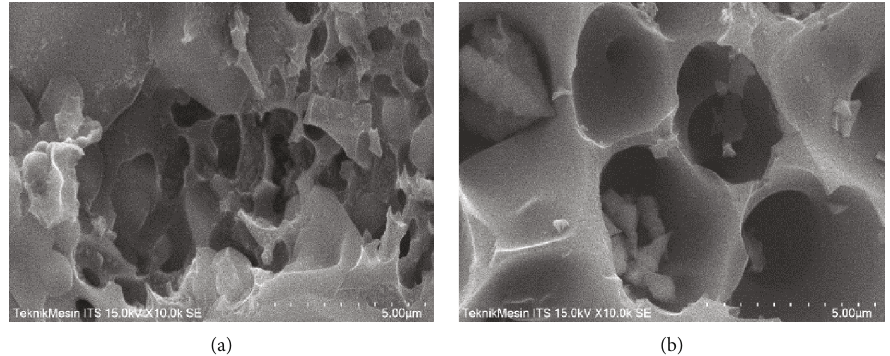
Figure 1: Scanning electron micrographs (SEM). (a) SSAC before adsorption. (b) SSAC after adsorption. Table 1: E ff ect of pH on adsorption of Cr(VI) using SSAC. Initial concentration of Final concentration Cr(VI) (mg/L)